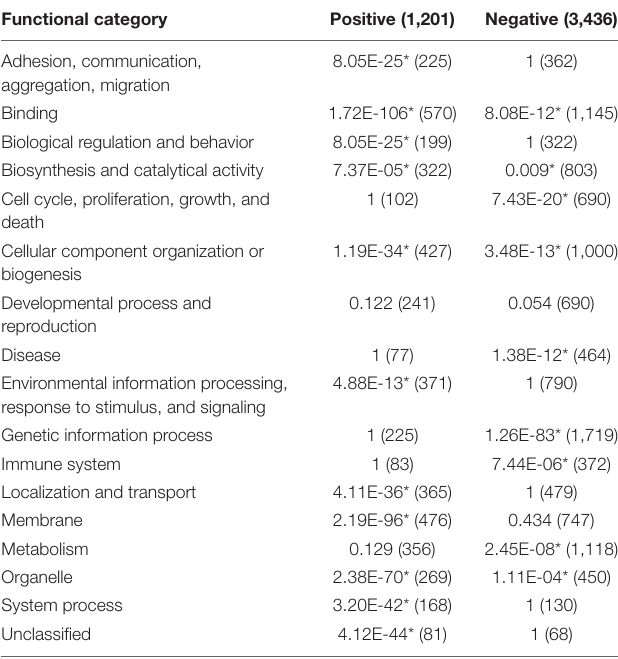
TABLE 1 | The 17 functional categories and their enrichment for either positive or negative main patterns (independent of time breaks).